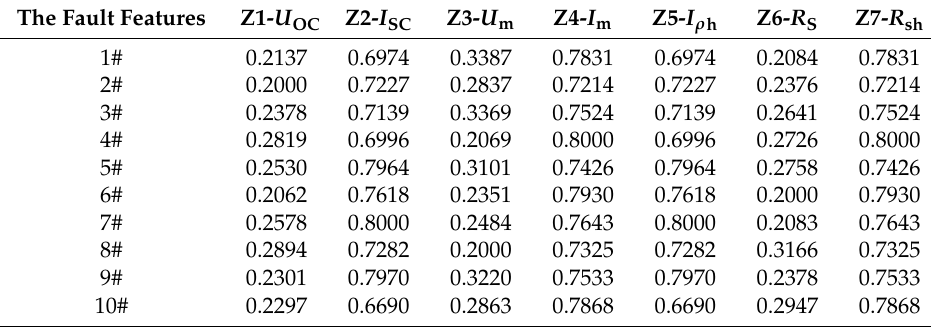
Table 2. The standardization data of the fault features of 10 test sample groups in short-circuits state.